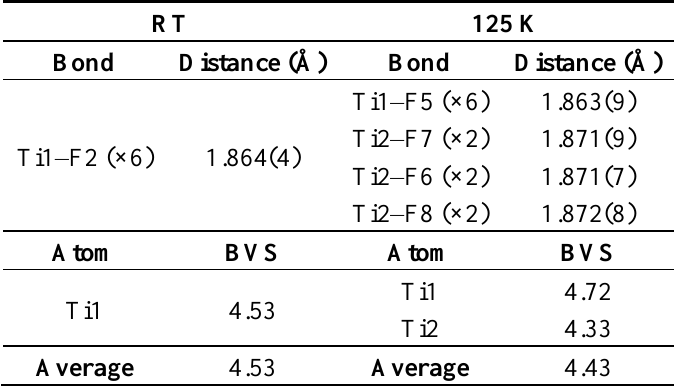
Table 3. Ti–F bond distances for Cs 2 TiCu 3 F 12 as found from SCXD at room temperature ( R 3̅ m ) and 125 K ( R 3̅ ) and BVS for Ti 4+ atoms at both room temperature and 125 K, calculated using VaList